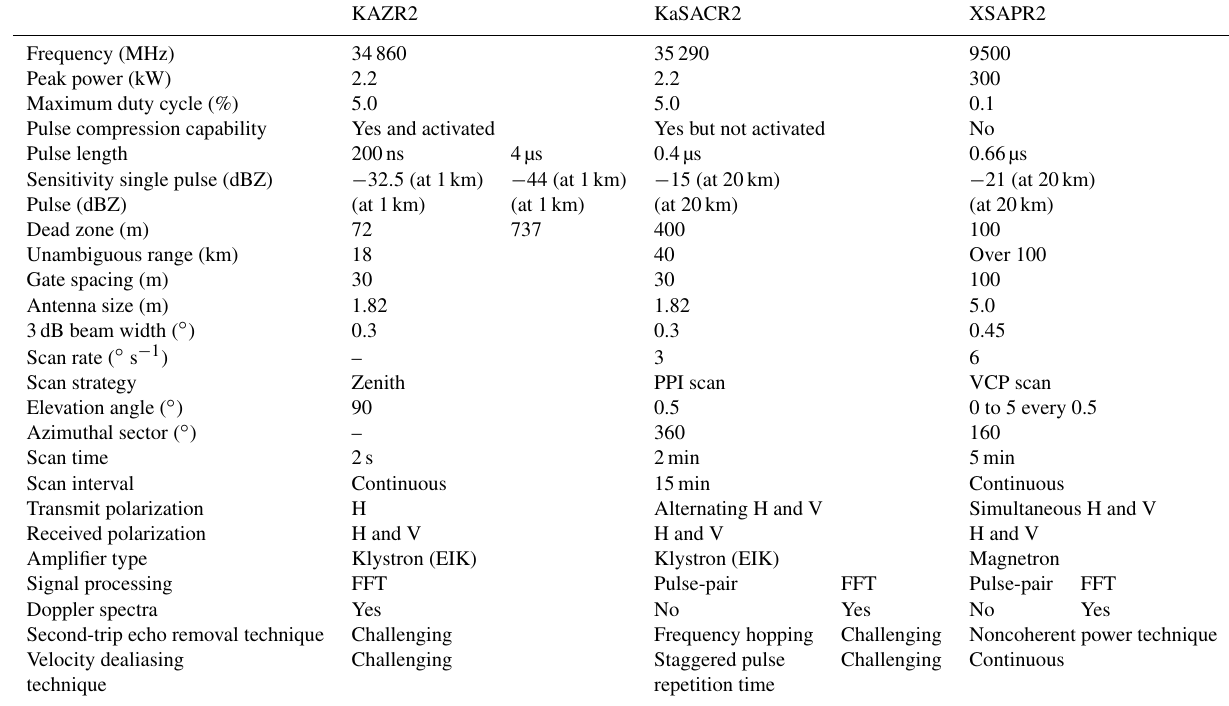
Table 1. Specification of ARM ENA zenith and scanning second-generation radar systems. KAZR2